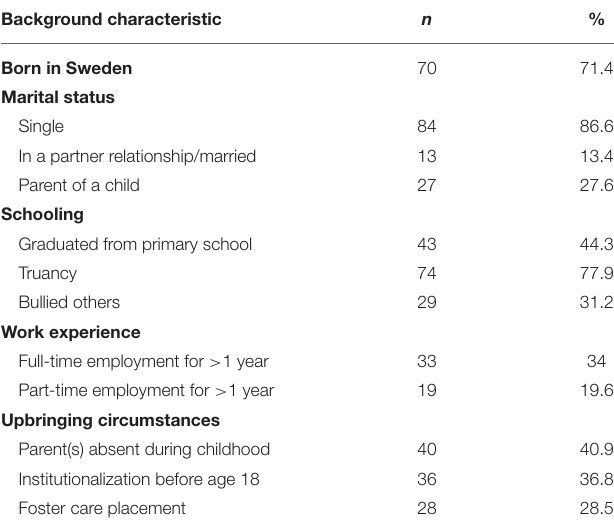
TABLE 1 | Psychosocial background of forensic psychiatric patients ( N = 98). Background